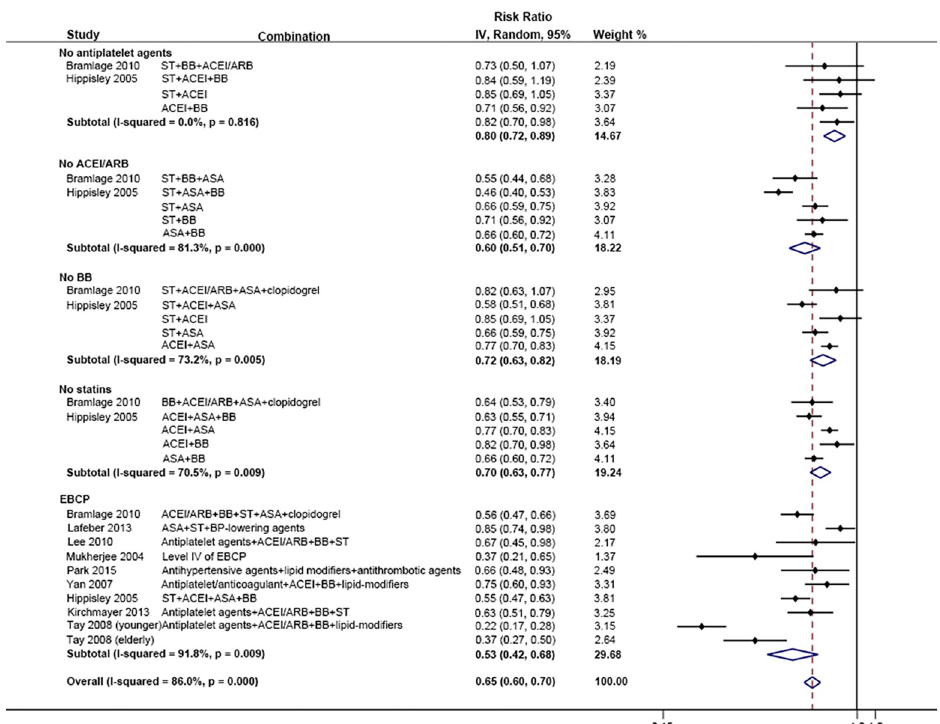
Fig 5. Comparison: Combination excluding one component versus 0–1 EB component, Outcome: All-cause mortality.